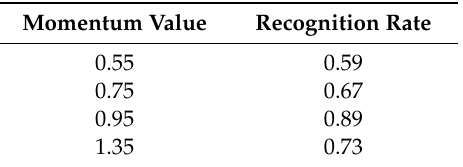
Table 2. Recognition rate under different momentum values.